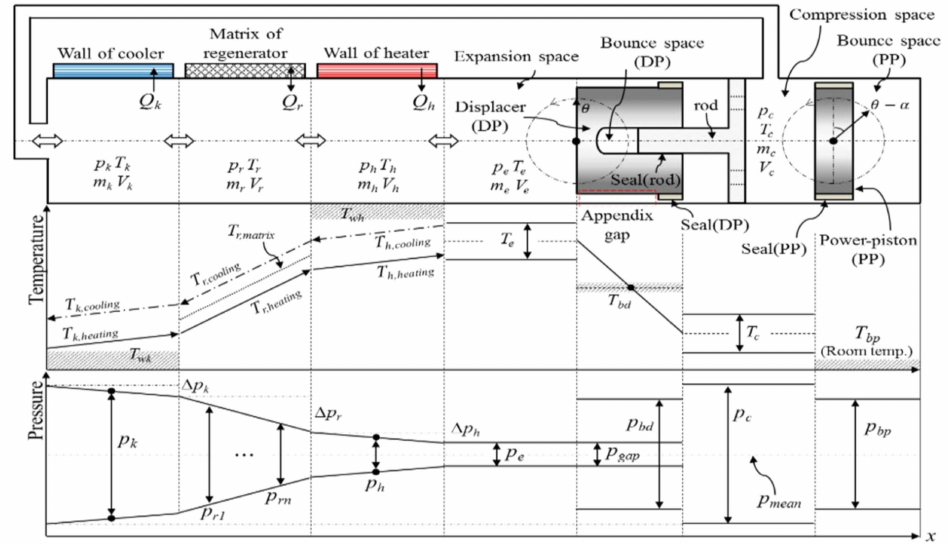
Figure 4. The thermodynamic system, temperature, and pressure levels of the